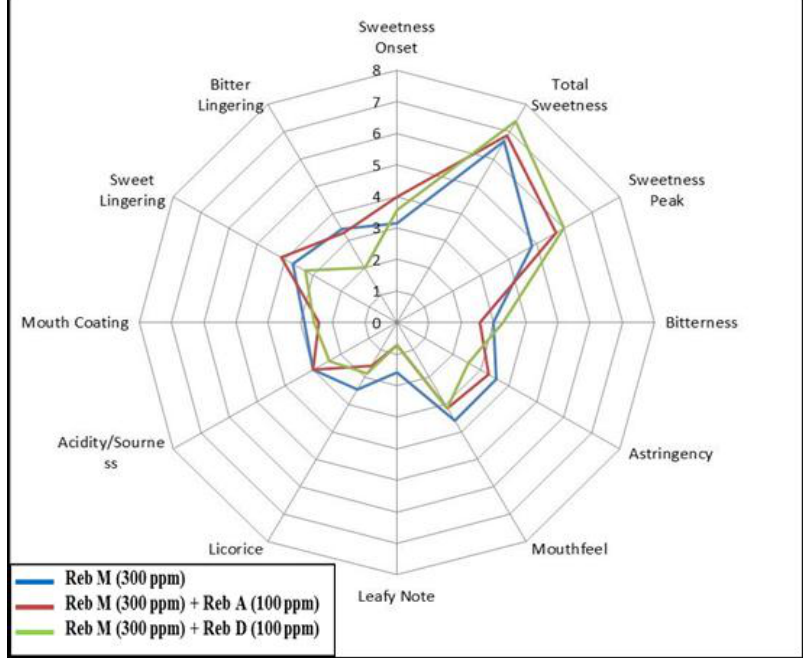
Figure 7. Sensory profile of di-blends of rebaudioside M ( 7 ) and rebaudioside A ( 1 ) or rebaudioside D ( 4 ) in acidified water.